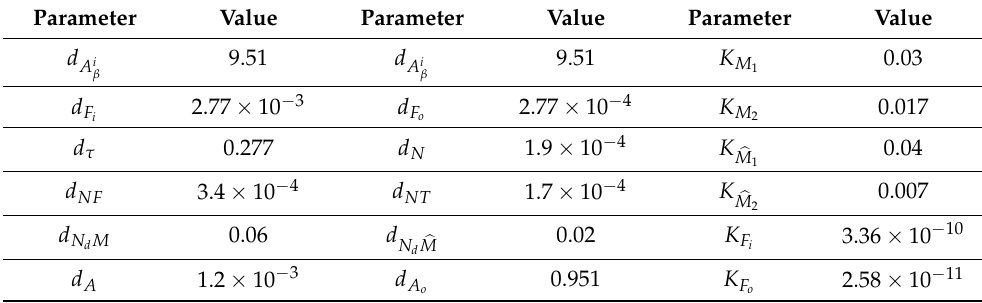
Table 1. Parameter